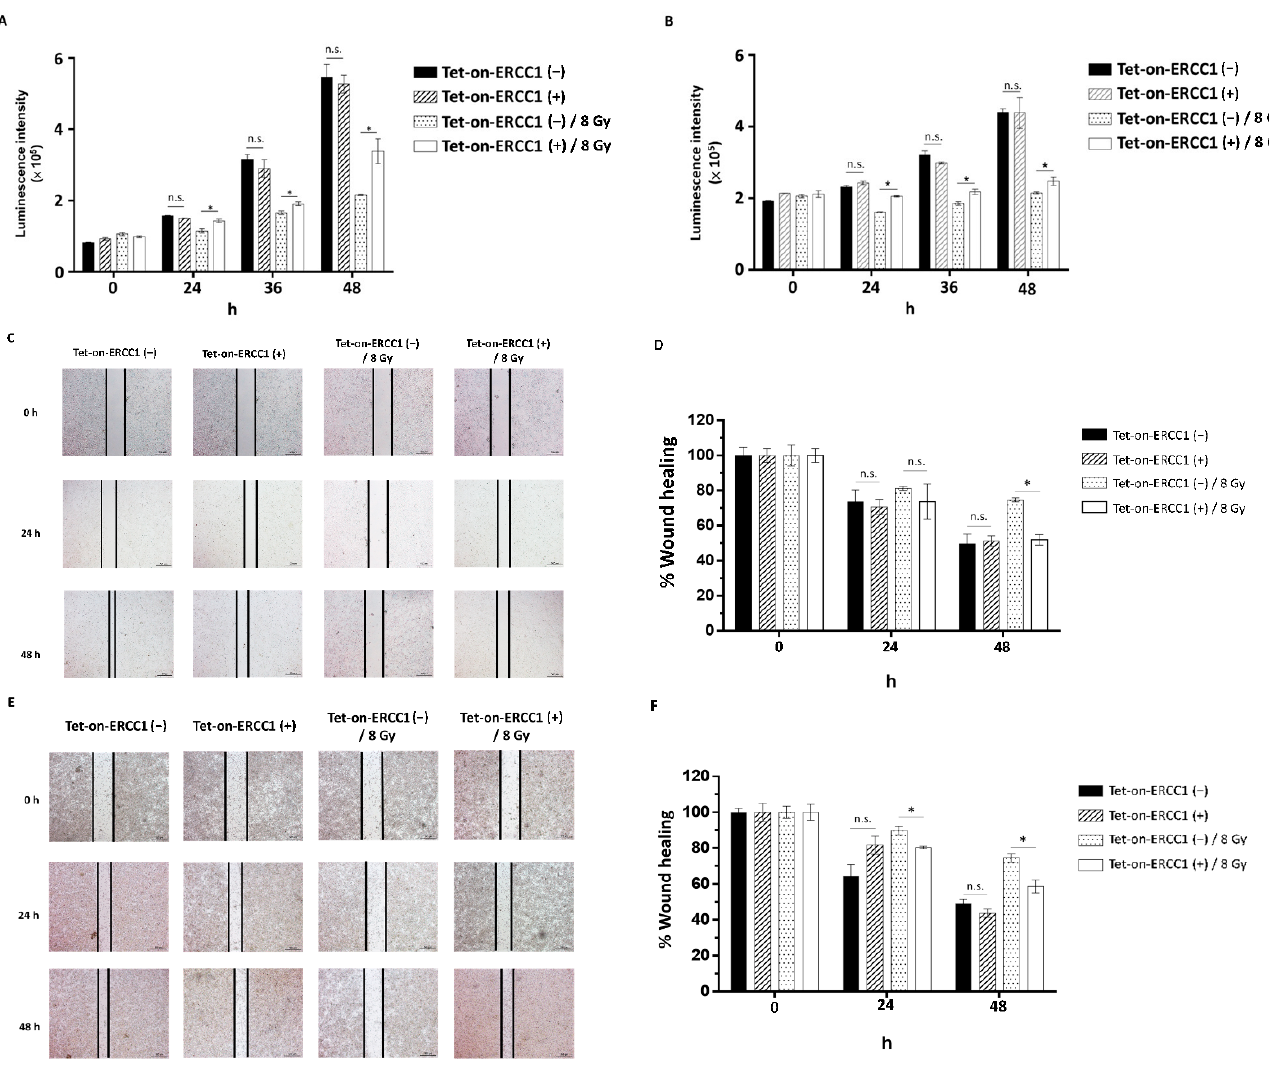
Figure 4. The effect of ERCC1 overexpression on cell proliferation and migration. HCT116-Tet-on- ERCC1 ( A ) and COLO 205-Tet-on-ERCC1 ( B ) were divided into a non-overexpression ERCC1 group, a Tet-on-ERCC1 (-) overexpression ERCC1 group, a Tet-on-ERCC1 (+) combined Tet-on- ERCC1 (-) with radiation exposure group (Tet-on-ERCC1 (-)/8 Gy), and a combined Tet-on-ERCC1 (+) with radiation exposure group (Tet-on-ERCC1 (+)/8 Gy). The luminescence intensity was ana- lyzed at 0 h, 24 h, 36 h, and 48 h. The abovementioned groups were seeded with 2 × 10 5 into 6 well dishes, and wounds were created at 0 h and photographed at 0 h, 24 h, and 48 h. The percentage of